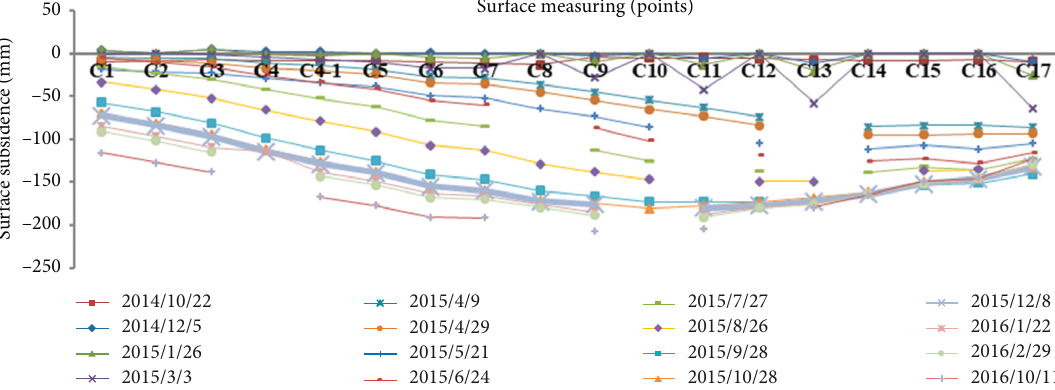
Figure 10: Record of dynamic subsidence of ground surface during working face